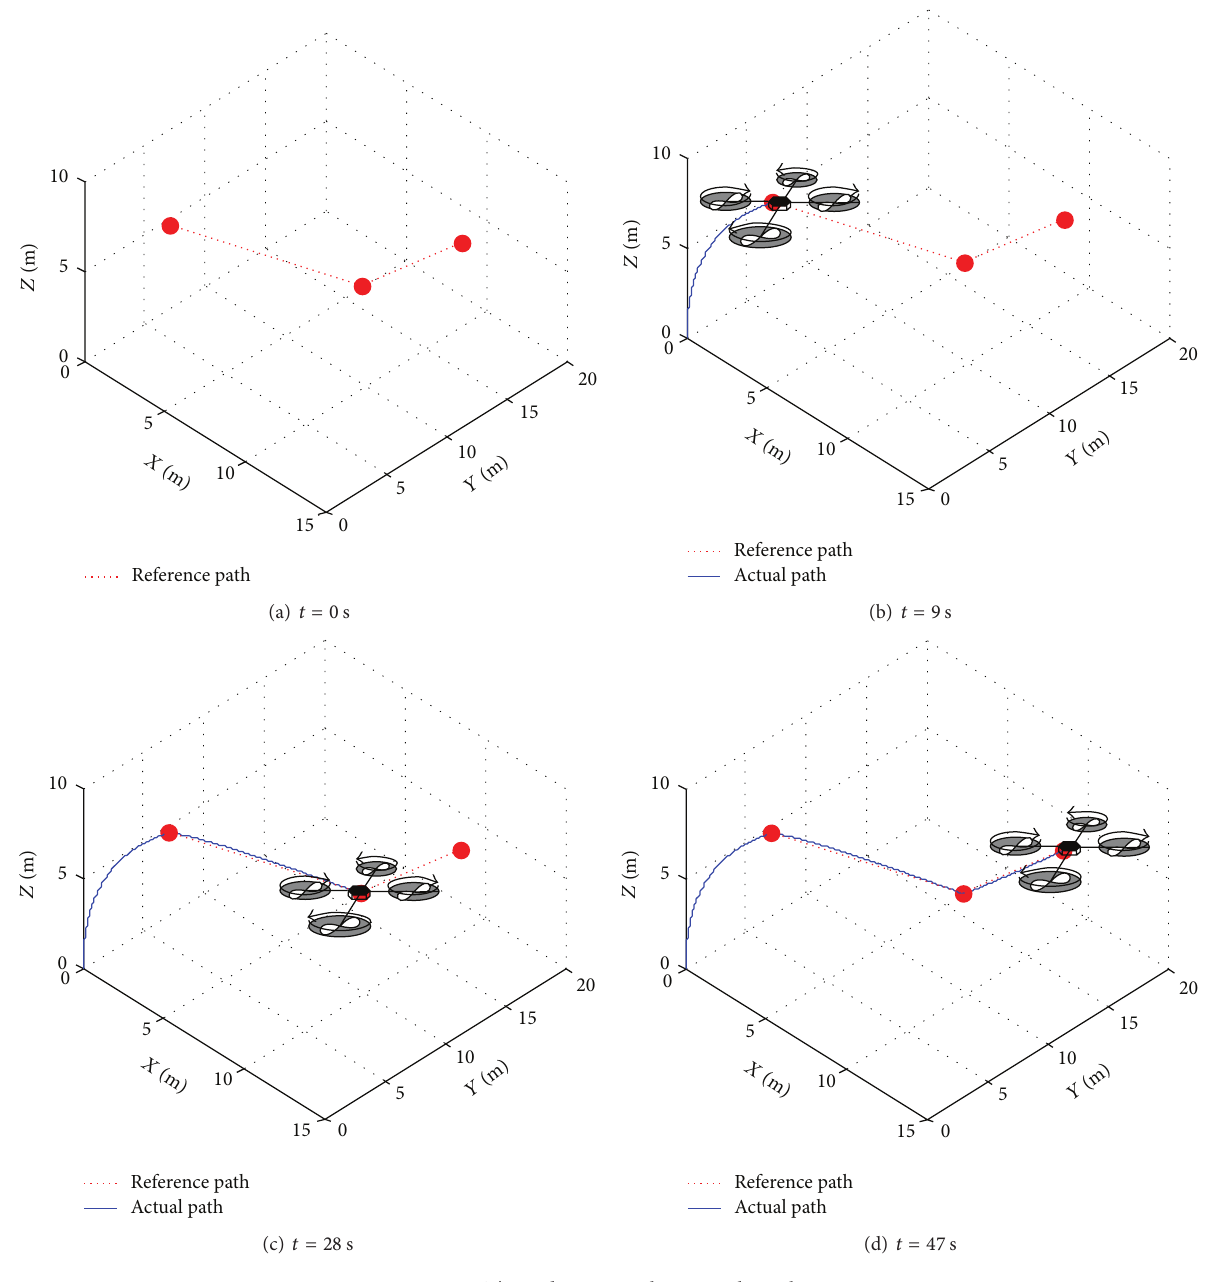
Figure 10: Three-dimensional UAV path